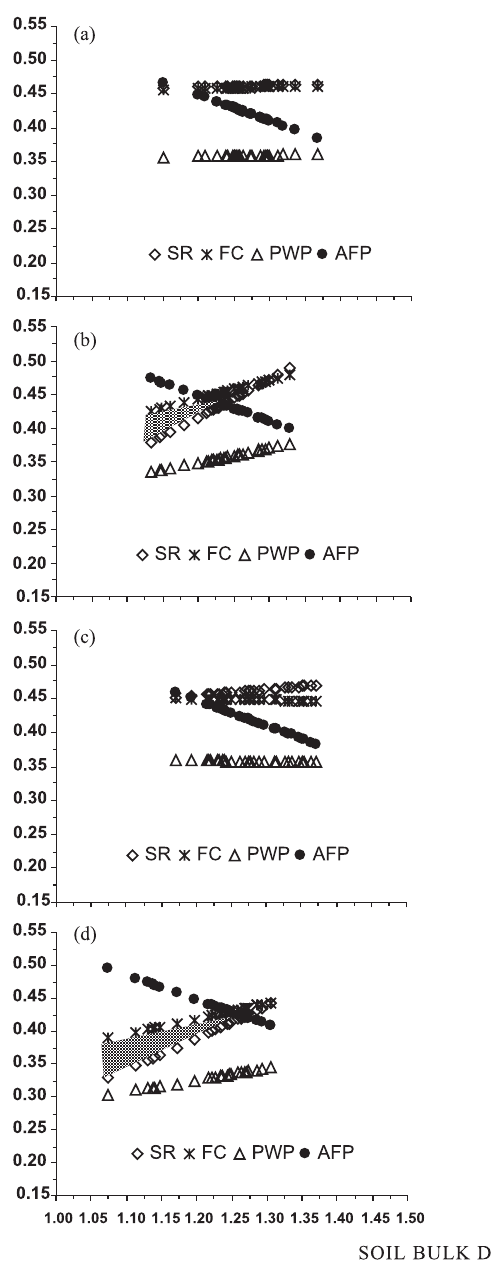
Figure 4. Soil water content ( θθθθθ ) as affected by soil bulk density, at the critical levels of field capacity (FC = -0.01 MPa), permanent wilting point (PWP = -1.5 MPa), air-filled porosity (AFP = 10 %) and soil penetration resistance (SR = 2MPa). Samples collected in the 20–40 cm layer, in the third year of the experiment. The shaded area represents the LLWR. (a) sunflower+millet; (b) sunflower+forage sorghum; (c) sunflower+sunn hemp; (d) sunflower+chiseling; (e) triticale+millet; (f) triticale+forage sorghum; (g) triticale+sunn hemp; (h)